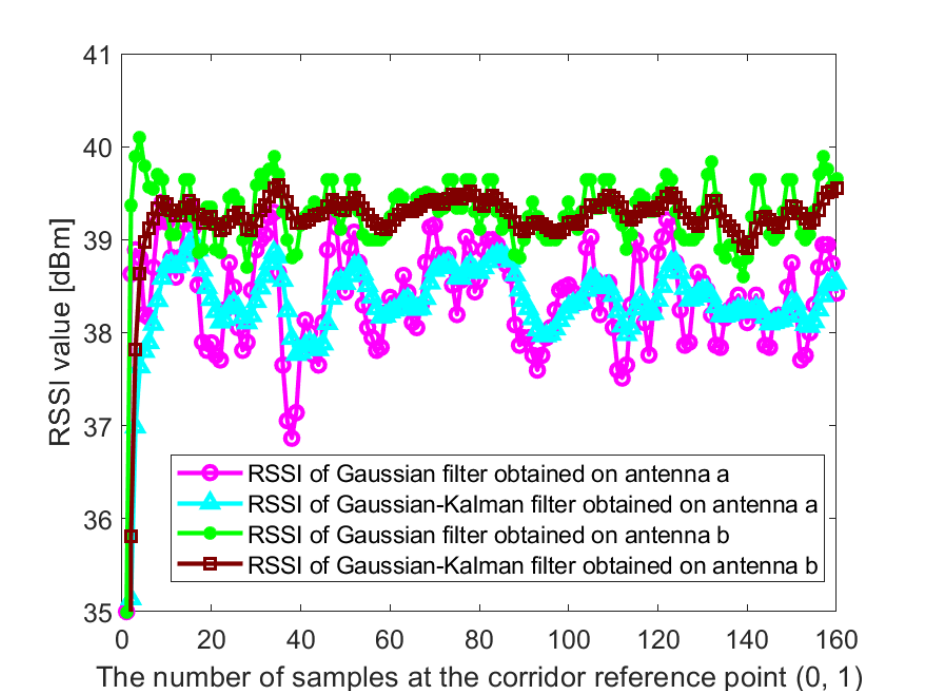
Figure 4. The Gaussian filtered RSSI value and the Gaussian-Kalman filtered RSSI value of AP1 on the effective antenna obtained at the reference point (0,1) in the corridor of IT1 building.